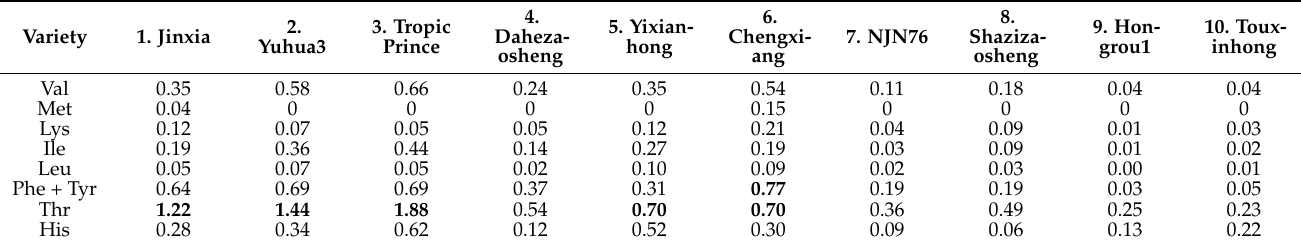
Table 4. Protein quality evaluation of peach ( Prunus persica L.) varieties by amino acid score method